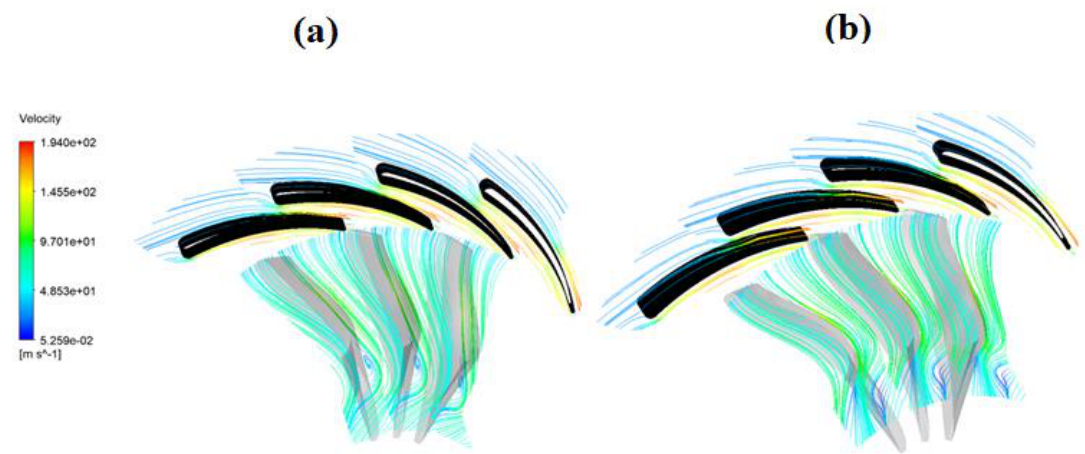
Figure 21. Velocity streamline at 50% span ( a ) and 90% span ( b ), at design point (N = 40,000 rpm, PR = 6.9).